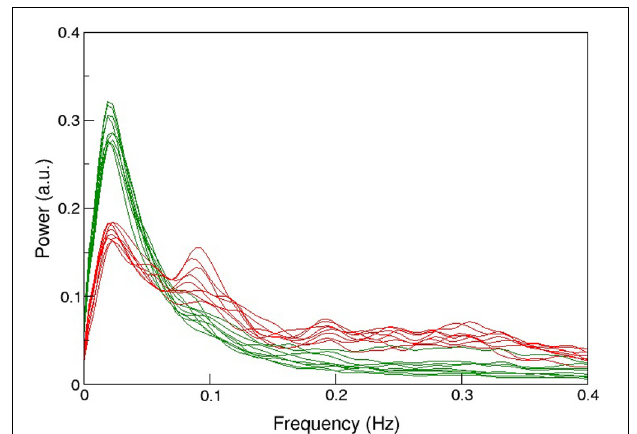
FIGURE 1 | Comparison of the mean spectral distribution of 12 resting-state networks shown in green (i.e., from medial visual, motor, cerebellum, lateral visual, posterior parietal, left-lateral fronto-parietal, temporal, medial frontal, default-mode, to limbic lobe, basal ganglia, right lateral fronto-parietal and anterior temporal lobe, in descending order of explained variance) and various physiological noise components in red. Experiments were performed at 3T ( n = 26), TR / TE = 1000/28ms (3 . 3 × 3 . 9 × 4mm 3 voxel resolution) during 5min, and at 4T ( n = 15), TR / TE = 2200/33ms (3 × 3 × 3mm 3 voxel resolution) during 10min sessions. For more details see Robinson [31]. Note the high power of noise components between 0.01 and 0.1Hz, not to be eliminated via bandpass filtering, and limiting the detection of more resting-state networks or subtle differences between networks in group